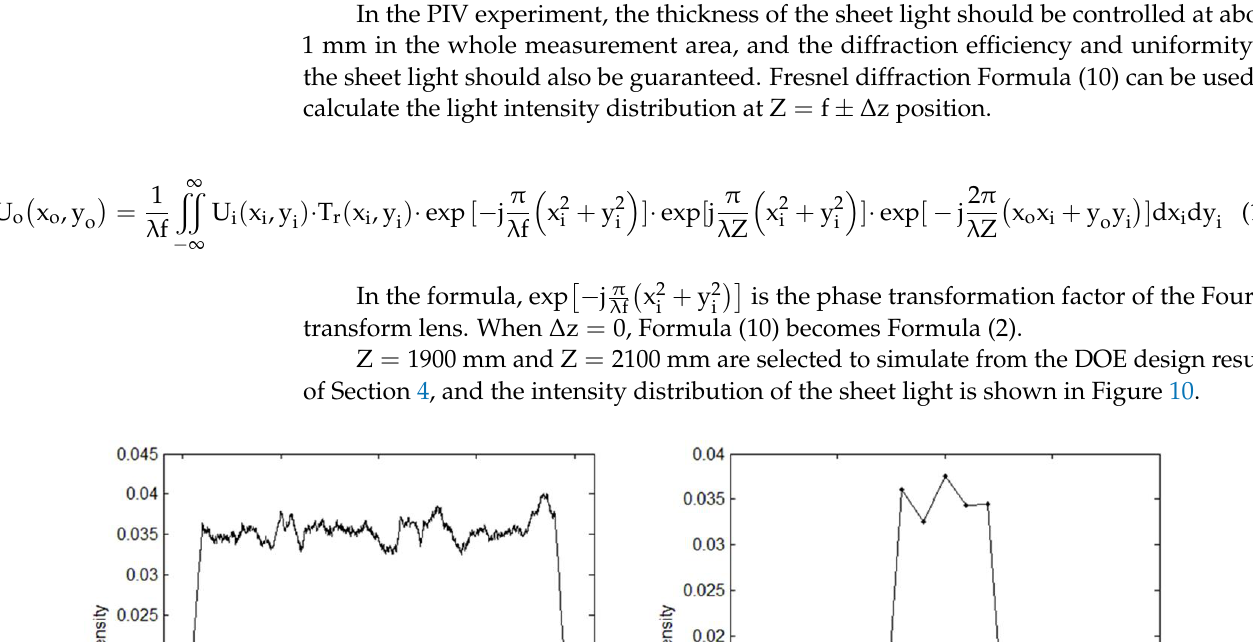
Figure 9. The DOE phase distribution along Y axis.